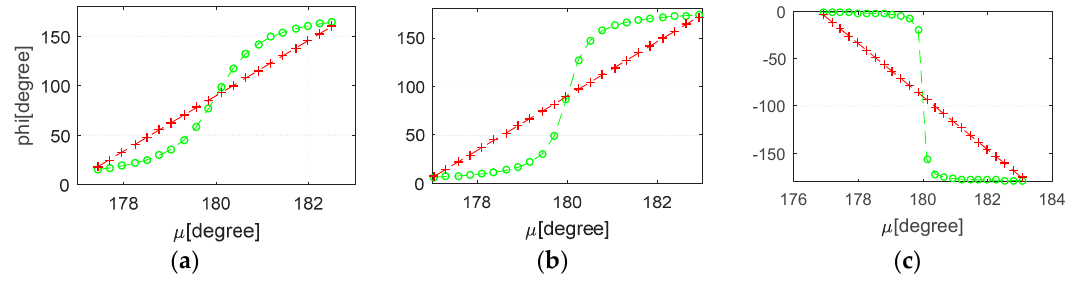
Figure 5. The yaw angle of R10 (M) during noon maneuver for different sun angles: ( a ) beta = − 0.70°; ( b ) beta = − 0.33°; and ( c ) beta = 0.05°. The nominal yaw angle is shown in green, while the modeled one is in red.